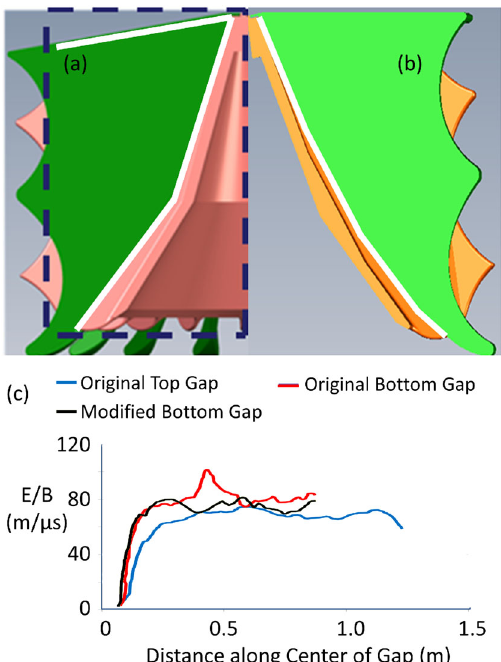
FIG. 25. The paths (in white) along which ratio j E j = j B j is computed for the top and bottom edge anode-cathode gaps for (a) the original geometry CSMITL and (b) the modified geometry CSMITL that straightens the path along the bottom edge. The ratio j E j = j B j along each path is shown for each of the three paths in